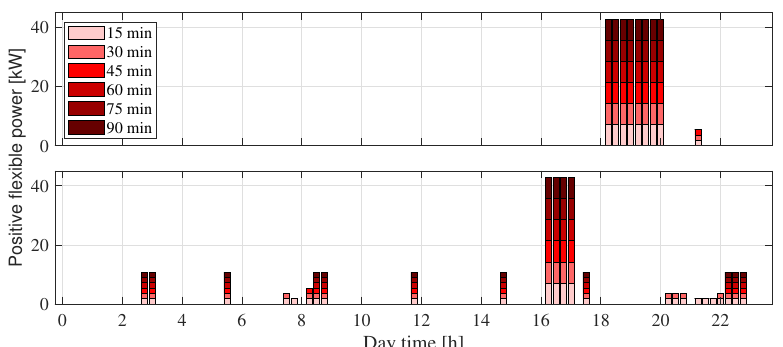
Figure 13. Calculated and communicated flexibility for the first day ( top ) and third day ( bottom ) of the simulation, for the first row of the flexibility matrix, which corresponds to a flexibility event starting in the next quarter